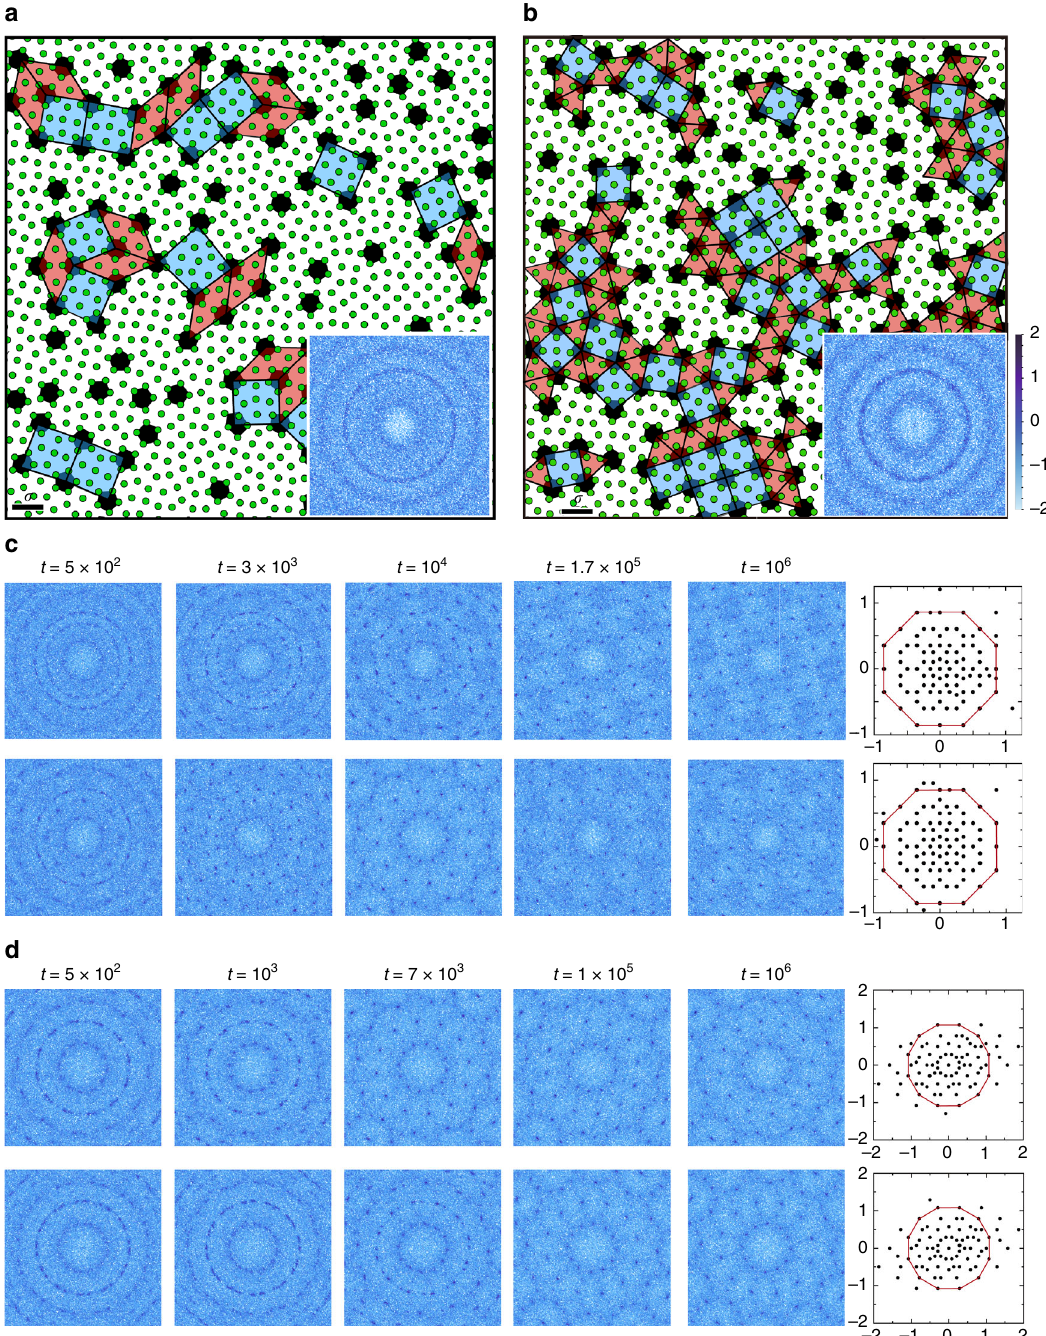
Fig. 5 Veri fi cation of route independence of the QC formation for systems with α = 2.0. a , b T = 0 con fi gurations obtained by quickly quenching ideal gas states to local potential energy minima at ρ = 6.50 and 6.80, respectively, where OQCs and DDQCs are supposed to exist. The black scale bars indicate the actual size of particle diameter σ . The squares, rhombi, and triangles are characteristic polygons to tessellate QCs, which are identi fi ed by connecting the centers of non-edge-adjacent pentagons. The insets are diffraction patterns of the T = 0 con fi gurations with the scale bar showing values in the logarithmic scale. c , d Time evolution of the diffraction patterns and projection of the long-time relaxed state in the perpendicular space (the rightmost panel) at ( ρ , T f ) = (6.50, 1.27 × 10 − 3 ) (OQC) and (6.80, 1.49 × 10 − 3 ) (DDQC) respectively, along two different routes. The initial states of the top and bottom panels are T = 0 states shown in a and b and equilibrated states at T > T = T = 0. The red polygons in m , respectively. Both types of states are suddenly brought to T f at t the perpendicular space are the atomic surface. All diffraction patterns are calculated based on centers of